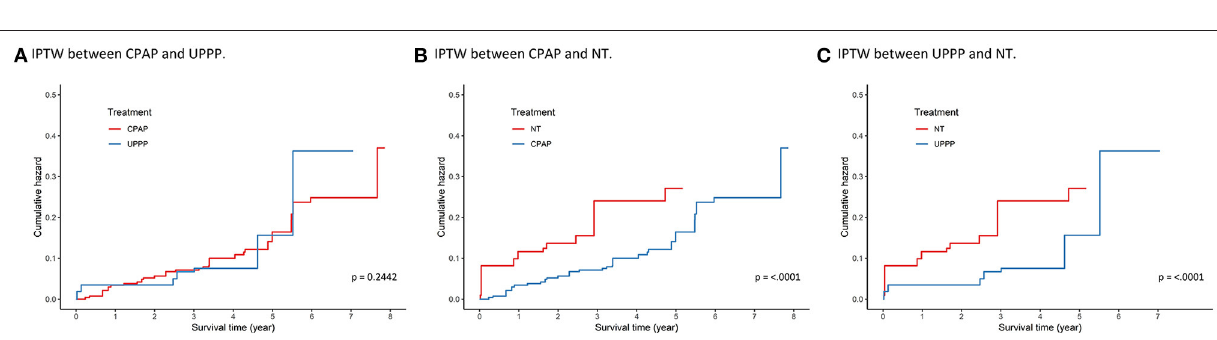
FIGURE 2 | Unadjusted cumulative hazard curve plot and adjusted cumulative hazard curve plot of HTN onset in the CPAP group, UPPP group and NT group, respectively. (A) Unadjusted cumulative hazard curves of incident HTN among the three groups were not significant ( p = 0.1551). (B) Adjusted cumulative hazard curves of incident HTN were adjusted by the age, sex, BMI, RDI, and status of comorbidities, including DM, CKD, CVD, HLD. The hazard curves were significant ( p = 0.0351).